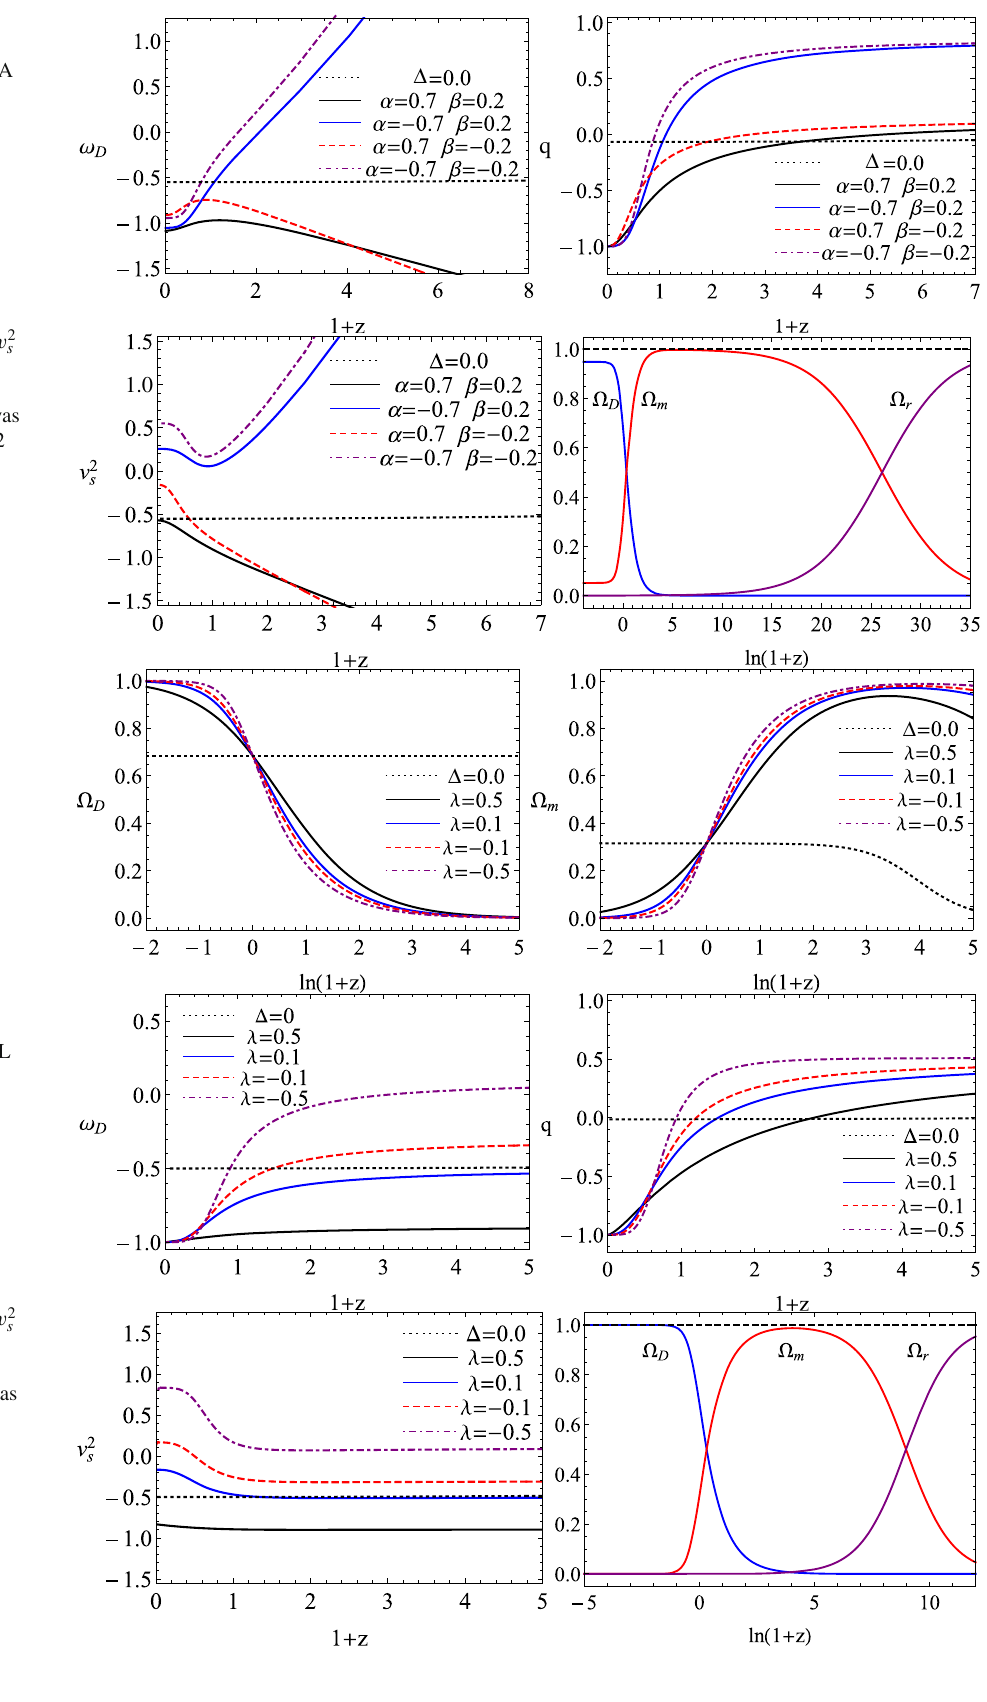
Fig. 14 Evolution curves of w D and q versus redshift parameter 1 + z for IBHDEHA